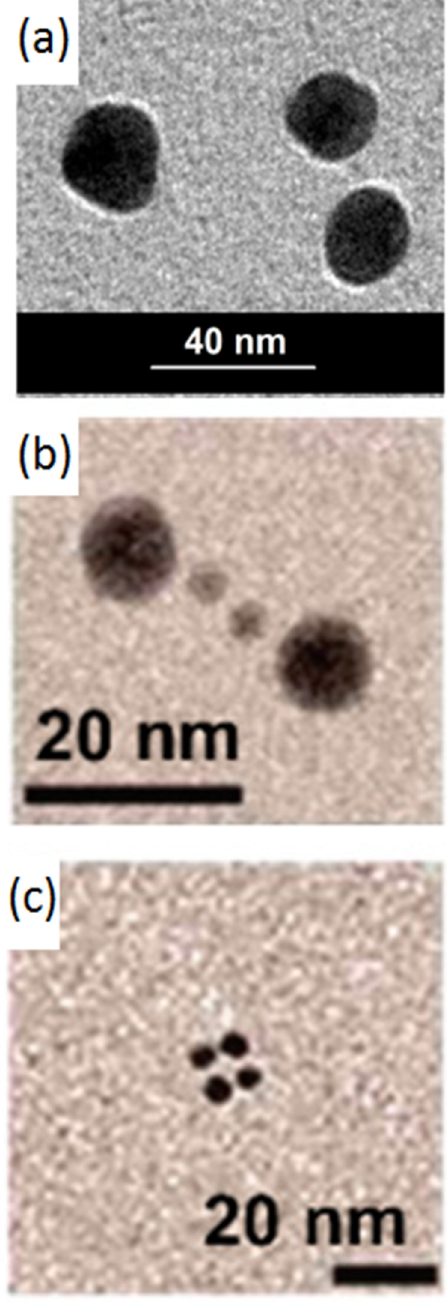
Figure 3. TEM images of AuNPs: ( a ) AuNPs with a diameter of 20–10 nm. Adapted from [153]; ( b ) Self assembled AuNPs with a dimension of 5–15 nm, functionalized by DNA. Adapted with permission from [154]. Copyright (2010) American Chemical Society; ( c ) Self assembled AuNPs with a dimension of 5 nm, functionalized by DNA. Adapted with permission from [154]. Copyright (2010) American Chemical